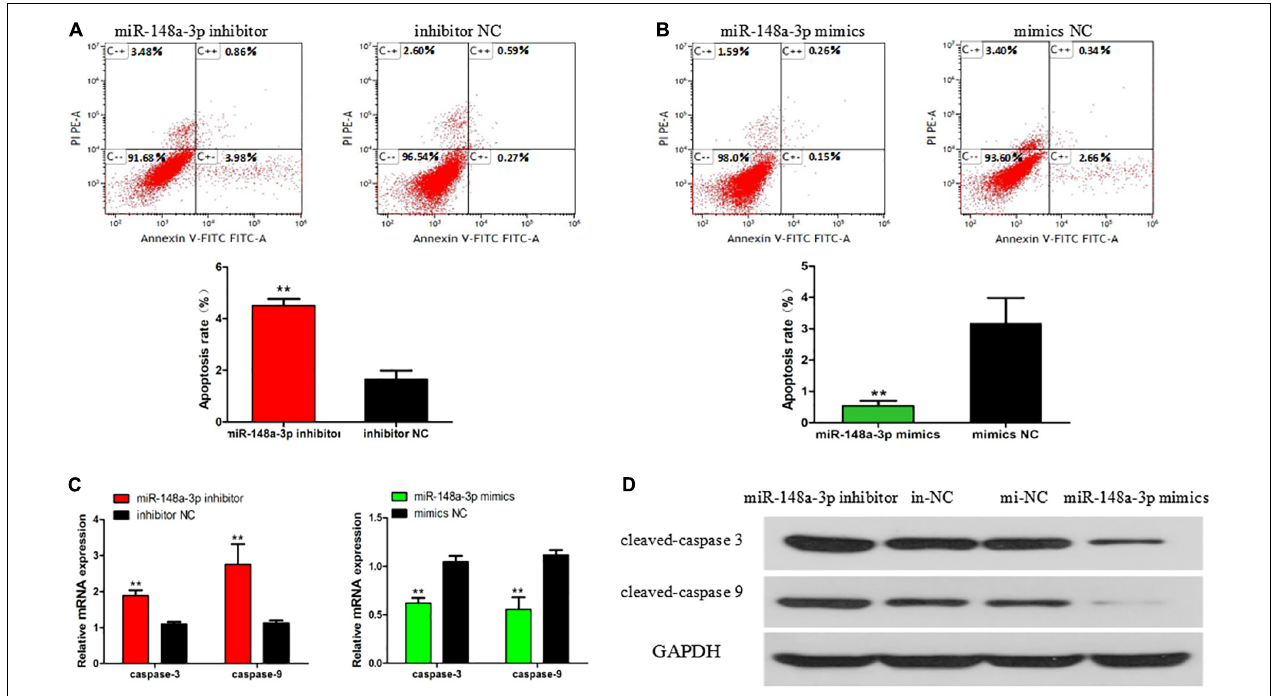
FIGURE 5 | Effect of miR-148a-3p on rate of apoptosis in SMSCs. Scattergram and rate of apoptosis in SMSCs transfected with miR-148a-3p inhibitor (A) or miR-148a-3p mimics (B) as analyzed using flow cytometry following staining with annexin V and PI. (C,D) Abundance of mRNA and proteins of caspase 3 and caspase 9 in SMSCs transfected with miR-148a-3p inhibitor and miR-148a-3p mimics as determined by use of Western blot analysis. Data are expressed as mean ± SEM ( N = 3). ** P < 0.01 vs.